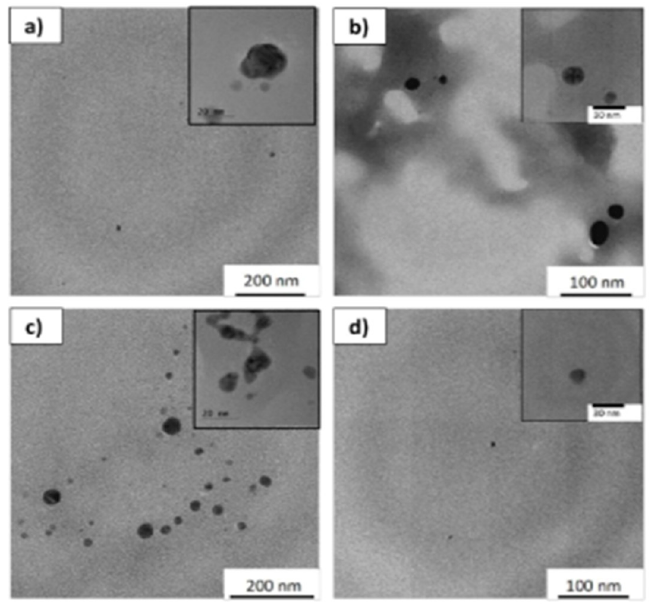
Figure 3. Morphology of silver NPs prepared using 150 µ L N 2 H 4 · H 2 O in the presence of indolicidin ( a ) and without indolicidin ( b ); 10 µ L N 2 H 4 · H 2 O in the presence of indolicidin ( c ) and without indolicidin ( d ).